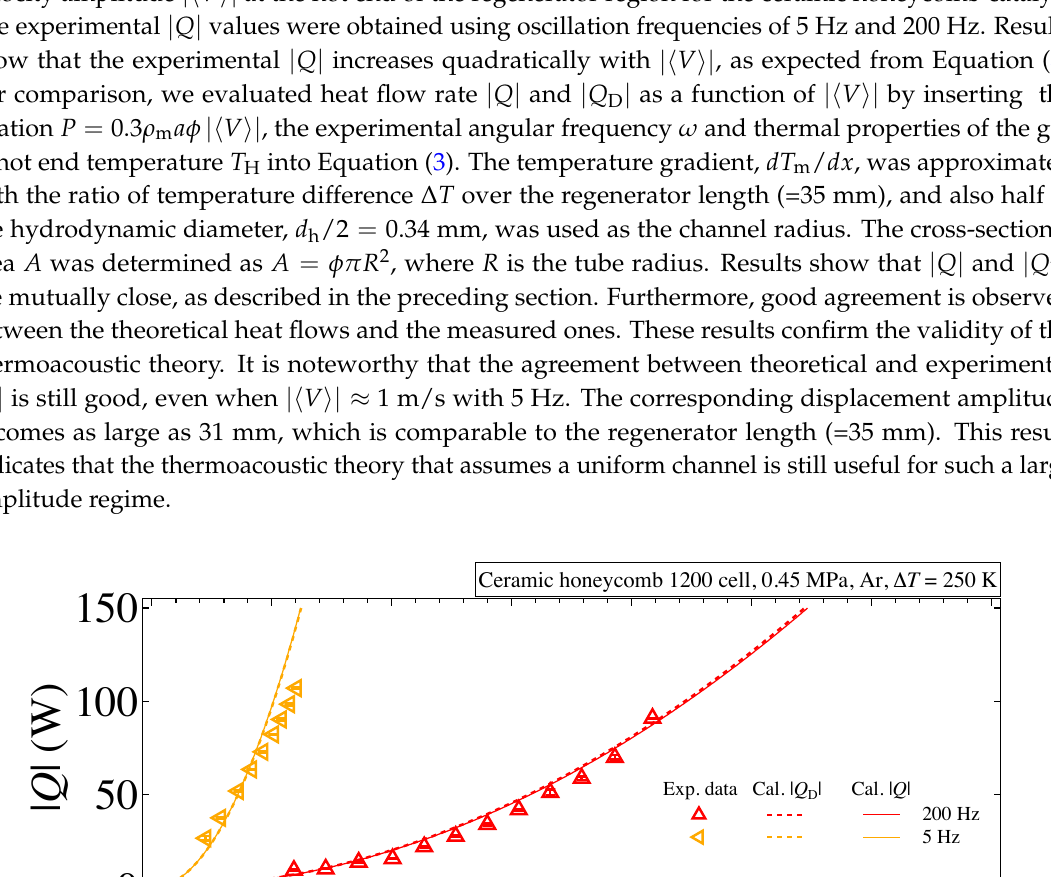
Figure 2. Comparison between the experimental heat flow rate by Equation (3) for the ceramic honeycomb catalyst, where experimentally obtained results are shown as symbols with error bars. The theoretical calculations of and dashed